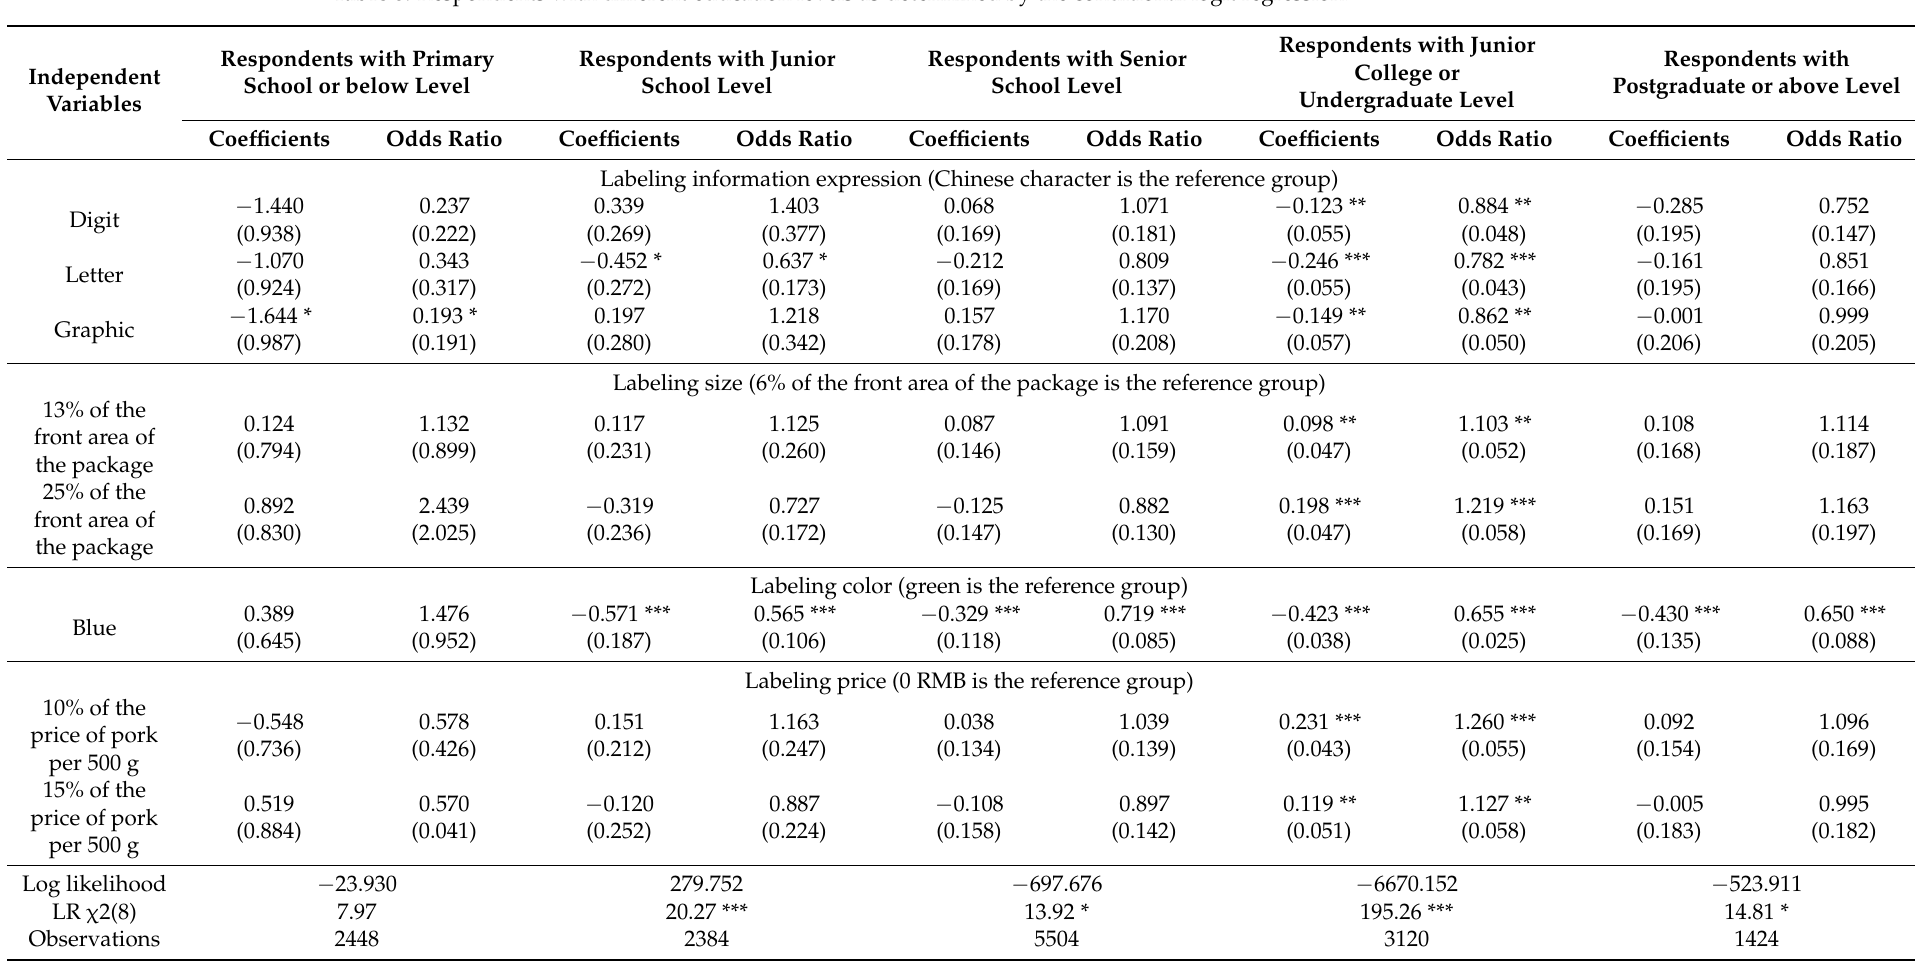
Table 8. Respondents with different education levels as determined by the conditional logit